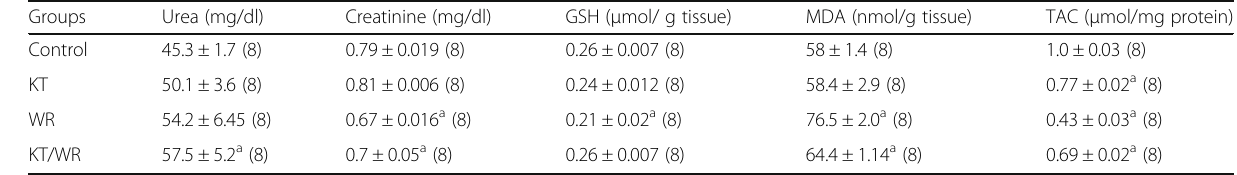
Table 1 Kidney function and oxidative stress parameters in ketorolac and warfarin treated rats. Groups